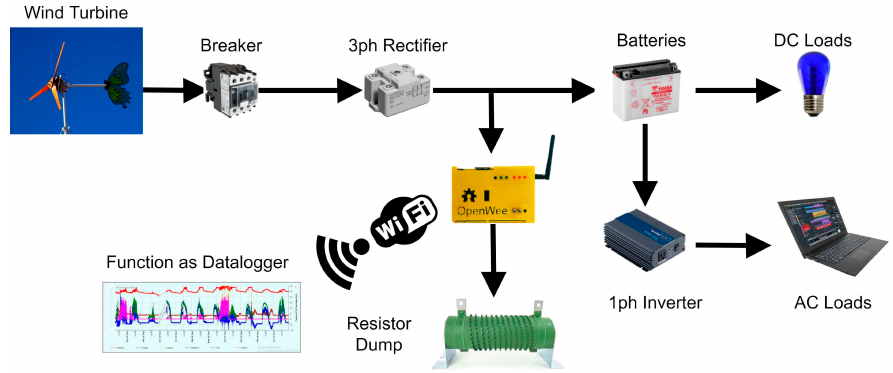
Figure 12. Description of hardware in the LCA-INTEQUI system [59].